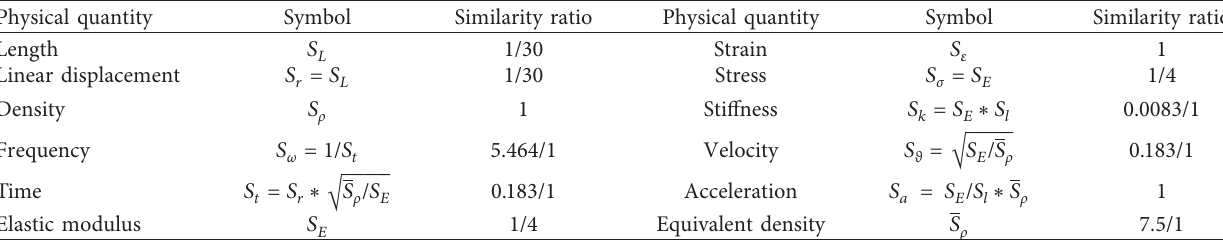
Table 2: Similarity rules of the model surface structure.